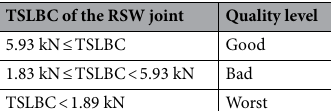
Table 4. The quality level classification of RSW